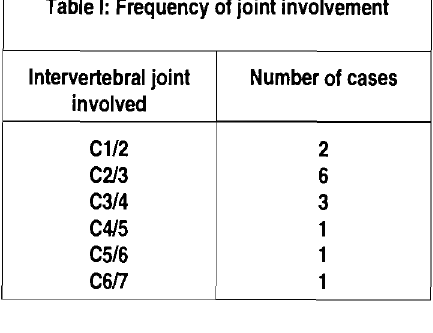
Table 1: Frequency of joint involvement